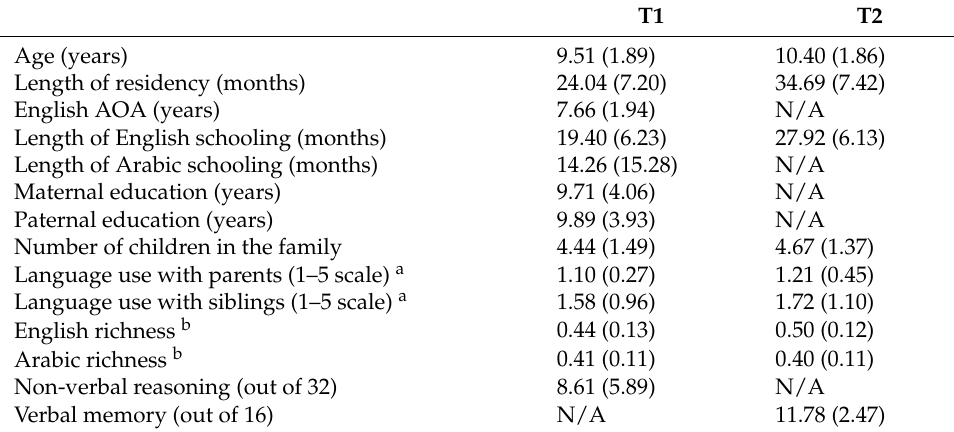
Table 3. Participant and family characteristics at T1 and